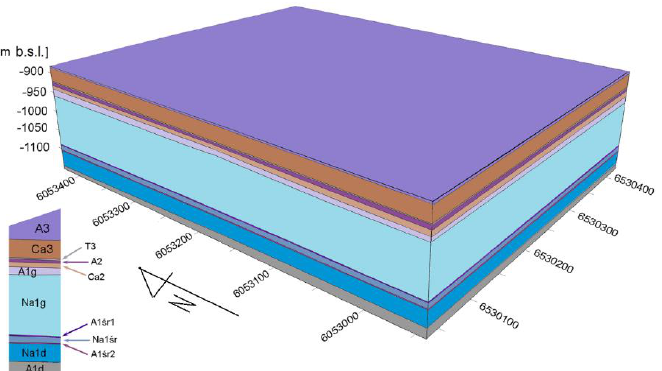
Figure 2. The geological structure of the Mechelinki salt deposit in the area of the underground store [21]. Table 2. Mechanical parameters applied in the geomechanical analysis.